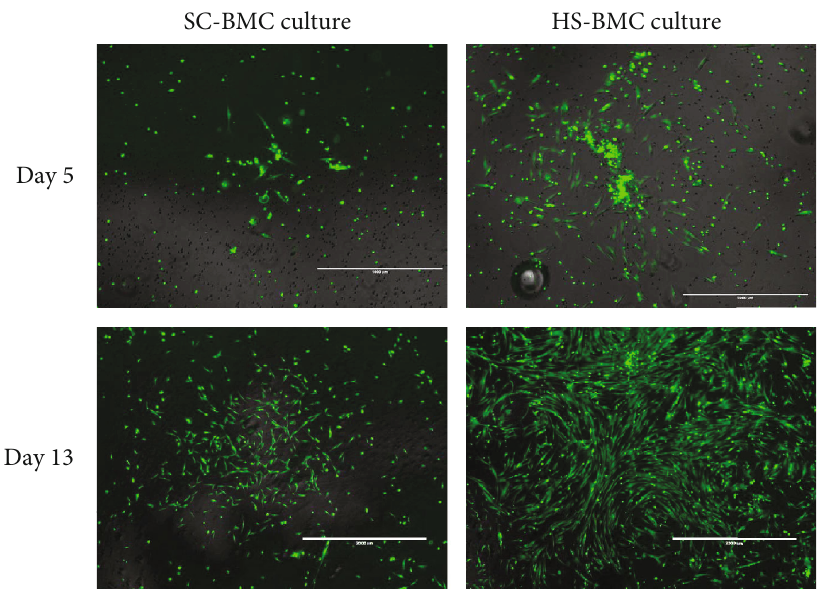
Figure 3: Calcein-AM-stained CFU-fs in culture from sodium citrate- (SC-) and heparin sodium- (HS-) derived BMCs at day 5 and day 13. BMCs imaged are donor matched. Day 5 micrographs were captured at 104x total magni fi cation, scale bar = 1,000 μ m. Day 13 micrographs were captured at 52x total magni fi cation, scale bar = 2,000 μ